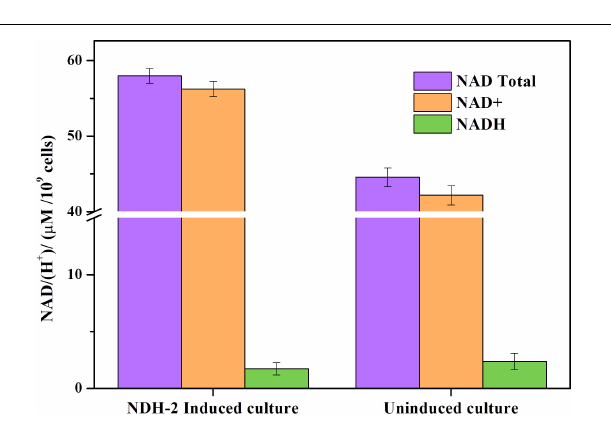
FIGURE 9 | Total NAD + , NAD + , and NADH concentration of aerobically grown cultures after 3 h of NDH-2 induction. NADH/H + concentrations were found to be very low corresponding to the high rate of catabolism and increased electron flux into electron transport chain.